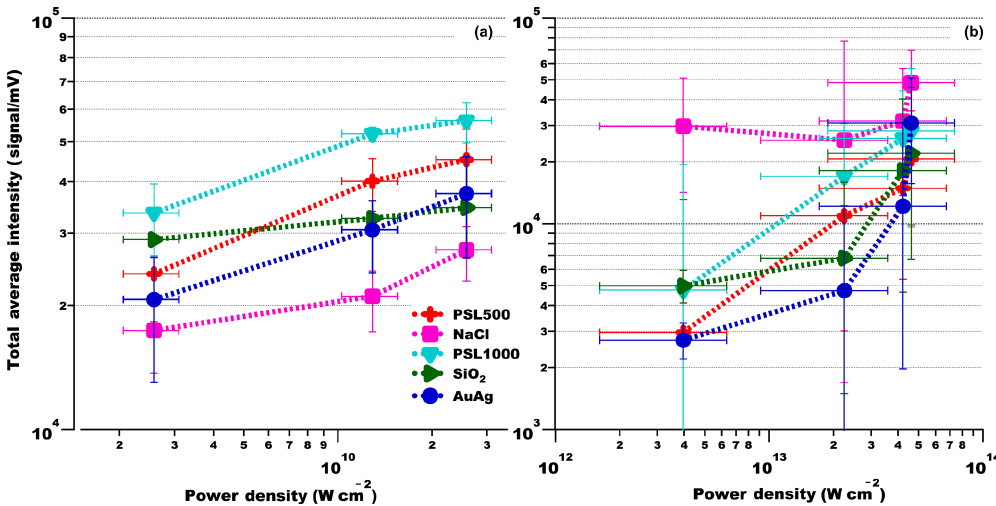
Figure 9. Average ion intensity versus laser power density for different particle types. (a) Excimer laser and (b) fs laser. Error bars of the average ion signal intensity correspond to ± 1 standard deviation, error bars of the power density to the value of power density of the laser beam at the corresponding possible maximum and minimum position of particle–laser